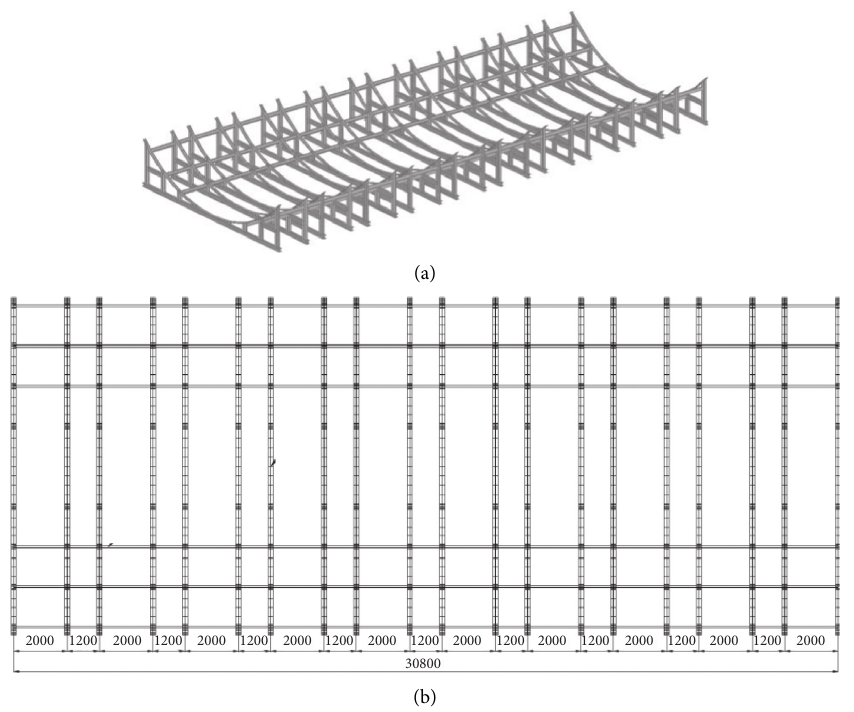
Figure 15: Assembly jig for auxiliary cell: (a) 3D model; (b) top